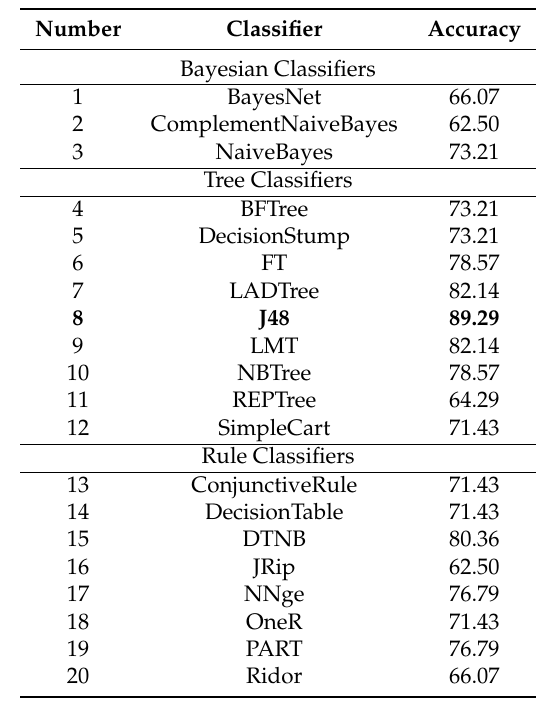
Table 7. Results obtained for different classifiers from the Weka